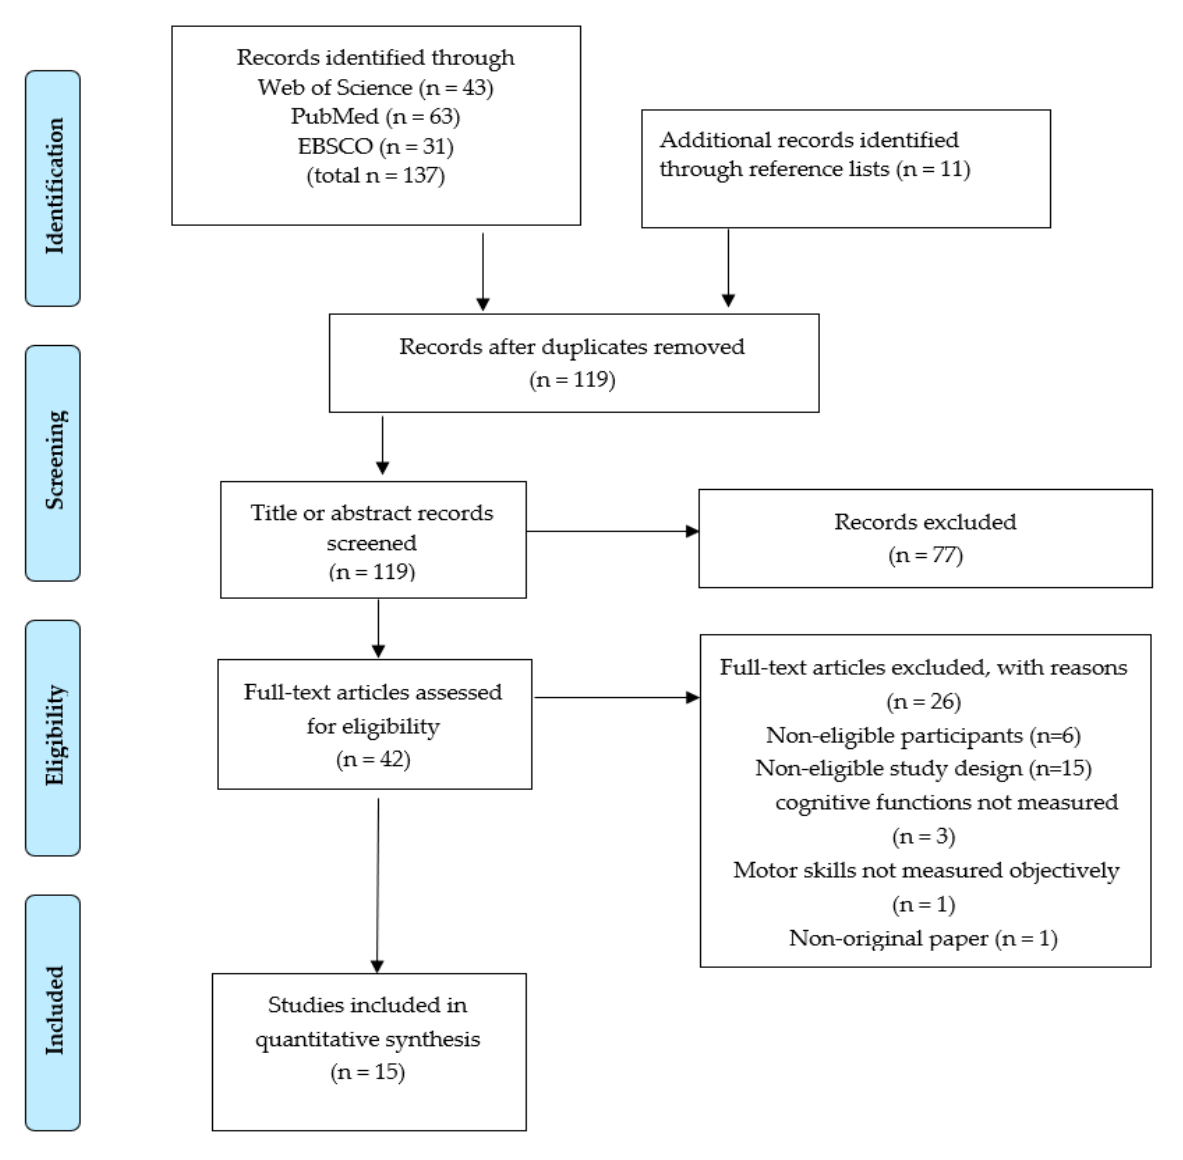
Figure 1. The process of article retrieval.